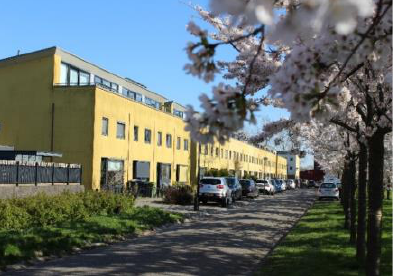
Figure 3. Cherry-lined avenue with yellow houses (courtesy of Author 2). Int. J. Environ. Res. Public Health 2020 , 17 , x FOR PEER REVIEW